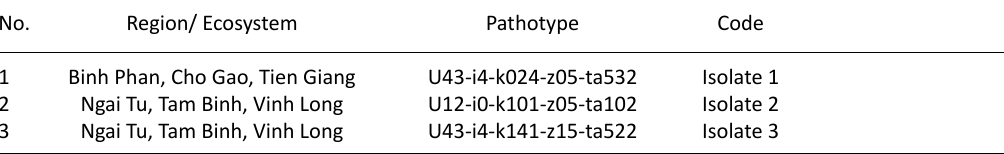
Table 2. Isolated designations of three fungus species from wild rice in the South of Vietnam